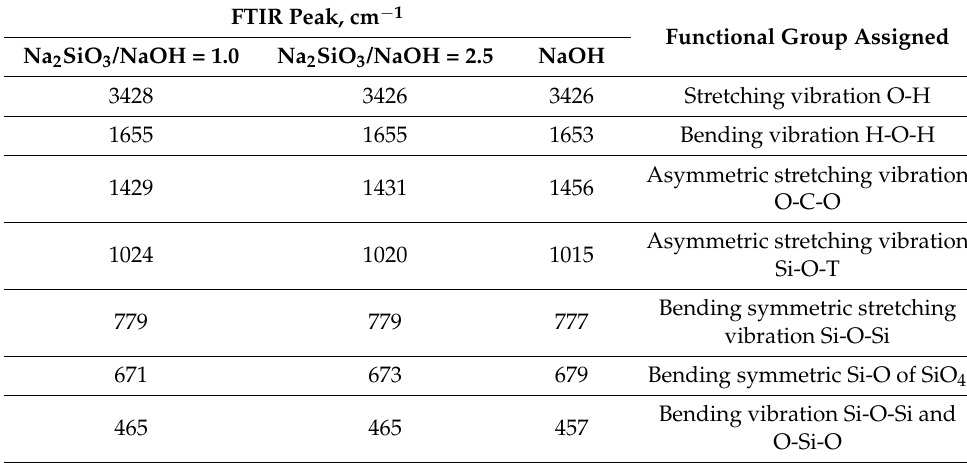
Table 3. Characteristic absorption peak of the FTIR